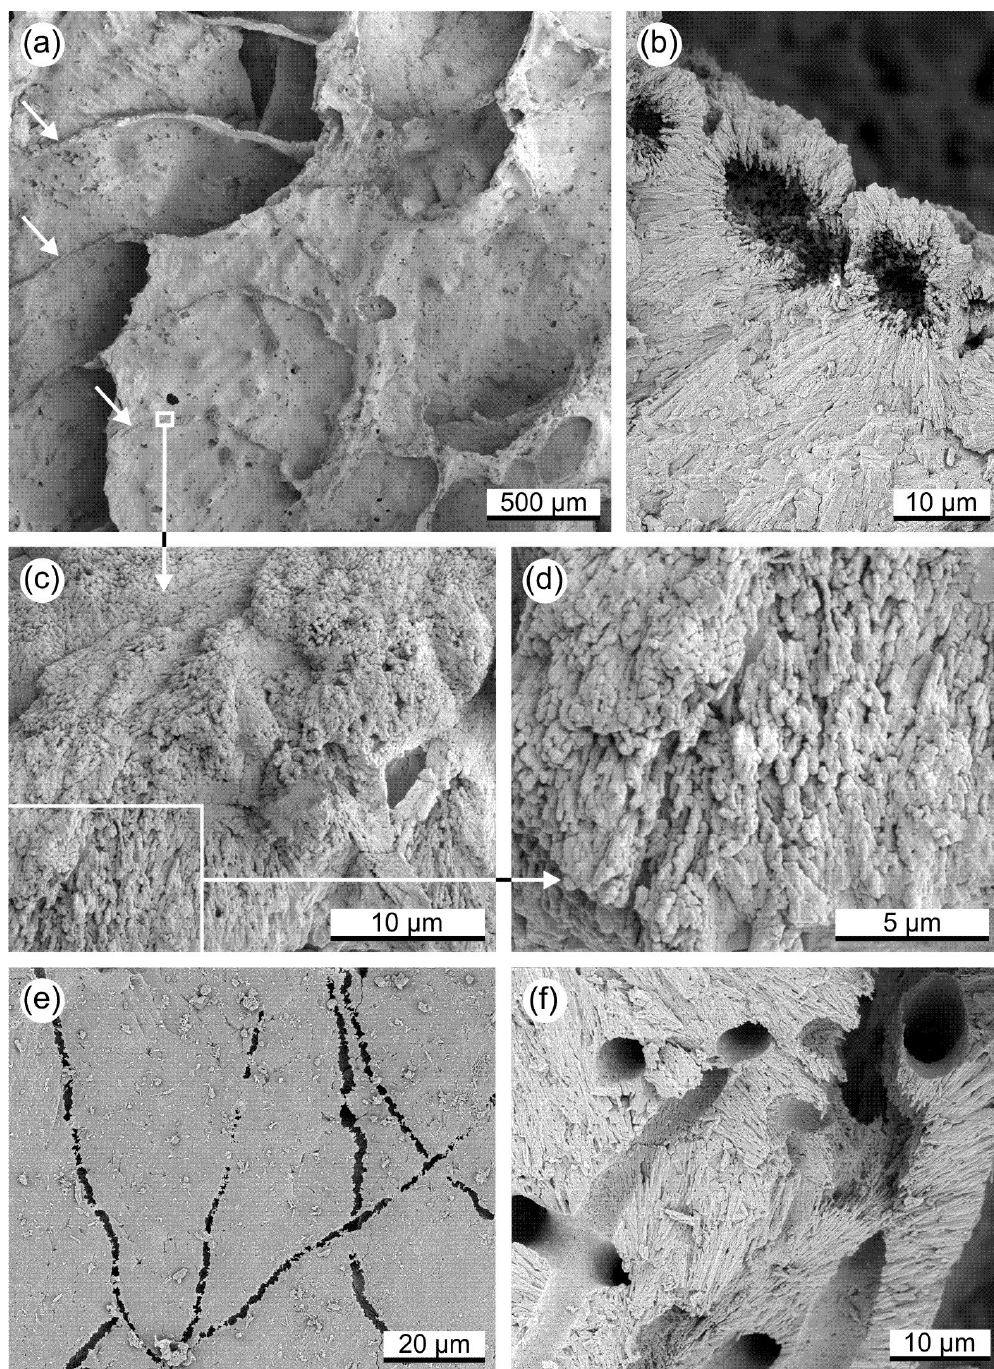
Figure 2. SEM images of fossil coral skeletons ( Solenastrea sp.). (a) Overview of septal surfaces. Curved ridges represent the traces of dismantled dissepiments (arrows). (b) Cross-section of the skeleton showing the radial arrangement of aragonite fibers. Note holes at the centres of the trabecular fans which likely reflects preferential dissolution. (c) and (d) cross-section of a dissepiment composed of fans of fibers pointing downward. The individual fibers have distinct rounded edges and rounded tips. (e) Primary surface of the skeleton infested by microborings. (f) Cross-section of the skeleton showing radial fiber crystals and numerous microborings. The microborings are not constricted by cement or overgrowths. Note: white rectangles and vertical and/or horizontal arrows show the position of close-ups. Sample provenance: (a) – (d) Solenastrea sp. (EP 6), Caloosahatchee Fm., Brantley Pit, Florida, USA; (e) Solenastrea sp. (EP 5), Tamiami Fm. (Golden Gate Mb.), Mule Pen quarry; (f) Solenastrea sp. (EP 9C), Bermont Fm., Palm Beach Aggregates quarry, Florida,